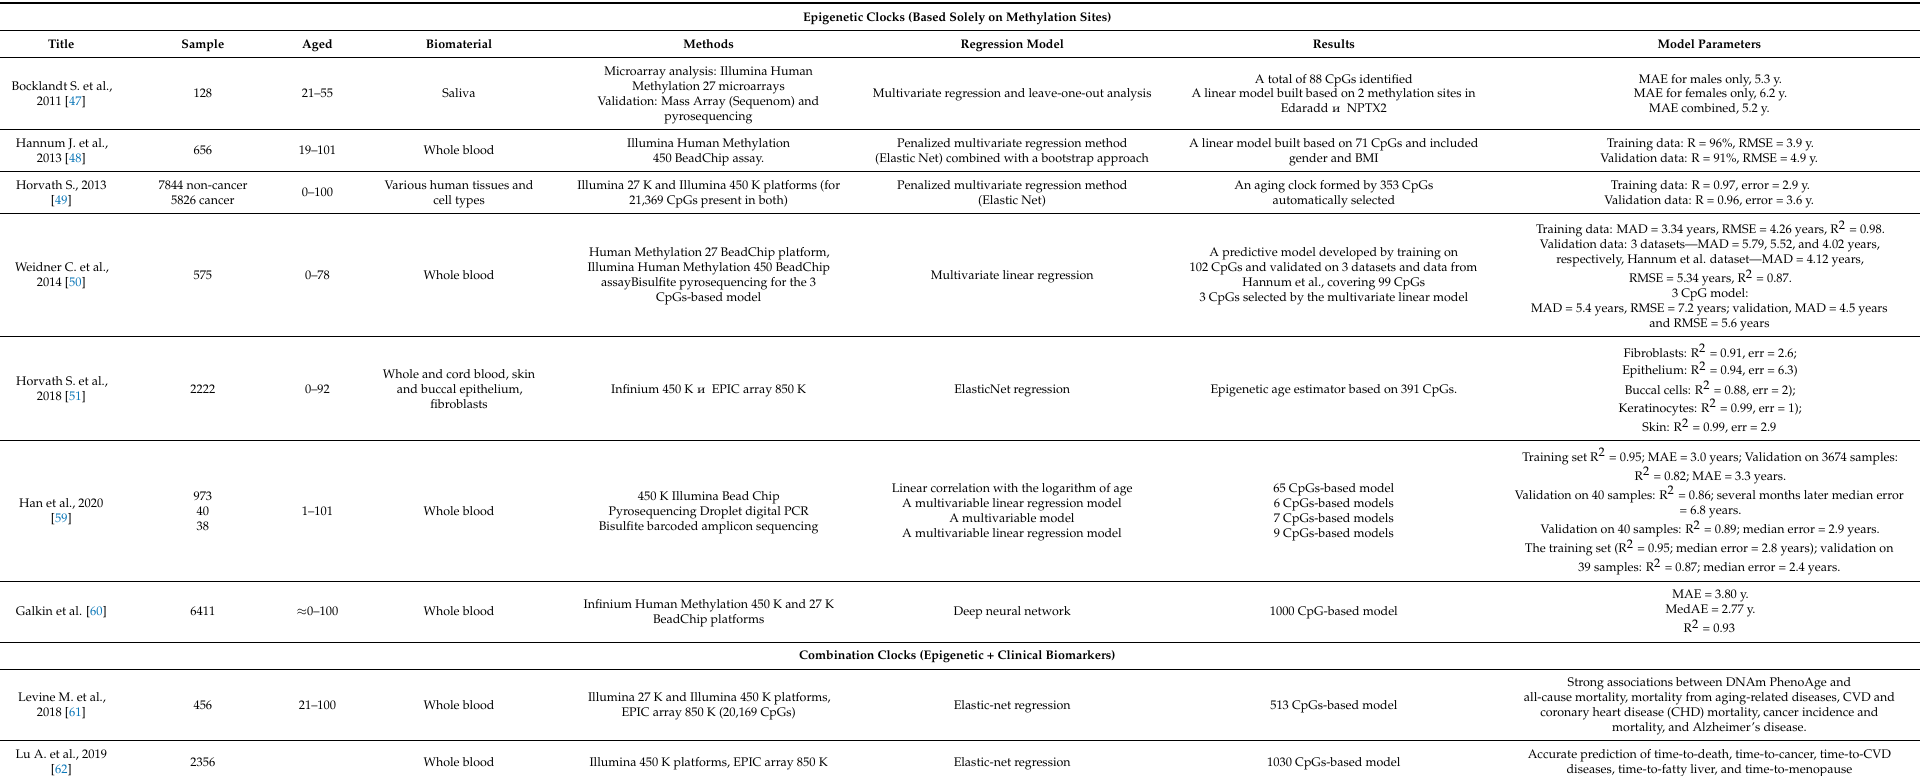
Table 3. Epigenetic clocks based solely on methylation